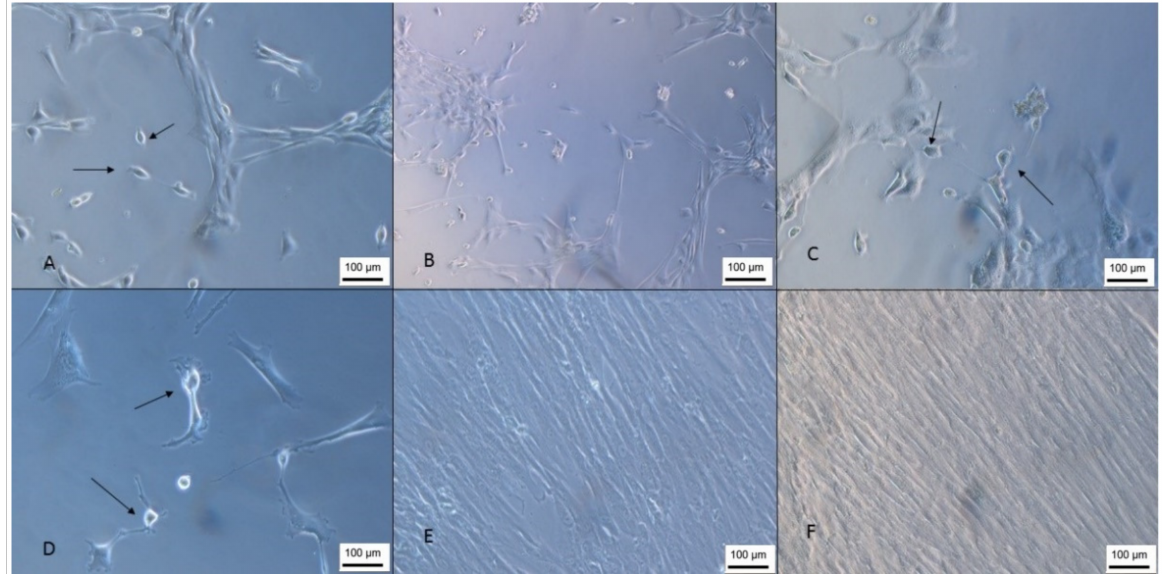
Figure 12. Cholinergic differentiation of Neural precursors. ( A ) Cells 4 days after initiation of induction (100 × ); ( B ) 8 days after induction (100 × ); ( C ) cells 10 days after induction (100 × ); ( D ) 14 days after induction (200 × ); ( E ) WJ-MSC control (100 × ); ( F ) Neural precursor control (100 × ) (inverted optical microscopy). Scale bar, 100 µ